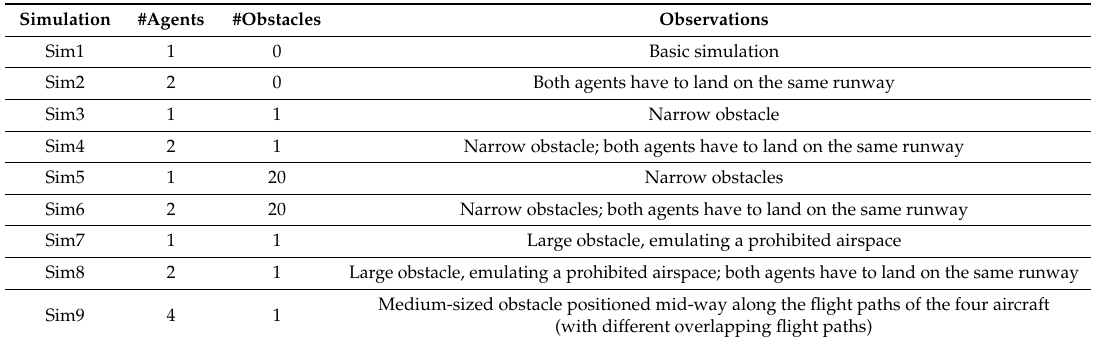
Table 4. Description of the designed learning